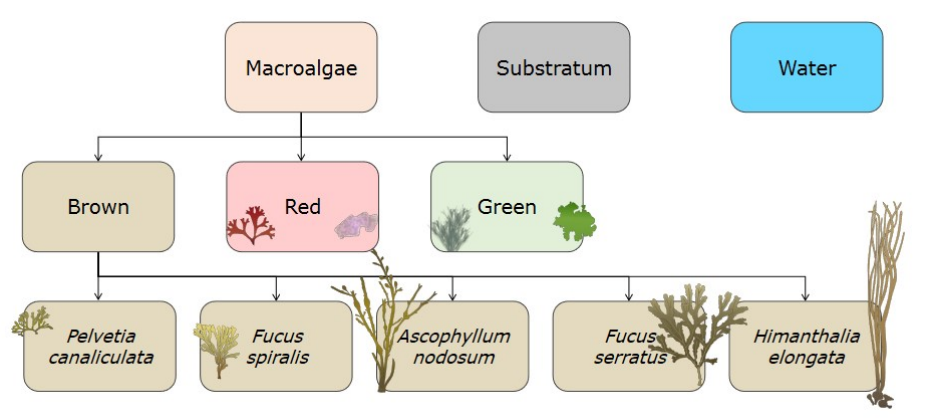
Figure 4. Hierarchical tree of decision to make classes, inspired from Congalton et al. (1999) [62]. Two supervised classification methods were performed to test the representativeness of the spectral classes running the software ENVI version 5.6.1 (Exelis Visual Information Solutions, Boulder, CO, USA), i.e., the algorithms maximum likelihood classification (MLC) and spectral angle mapper (SAM).